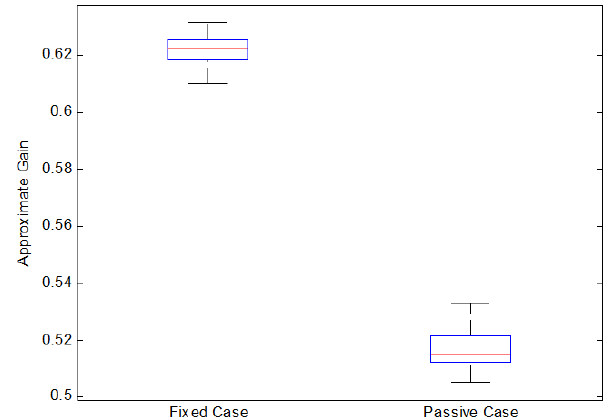
Figure 4. Quarter Car Experimental Setup.